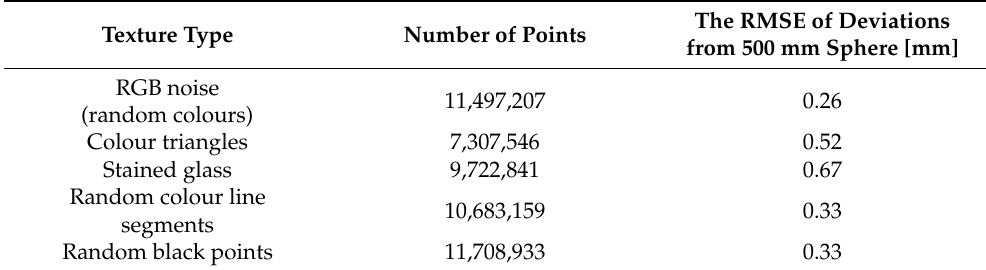
Table 1. Comparison of reconstructions of the same sphere in a single scenario with different textures with number of points and reconstruction accuracy.